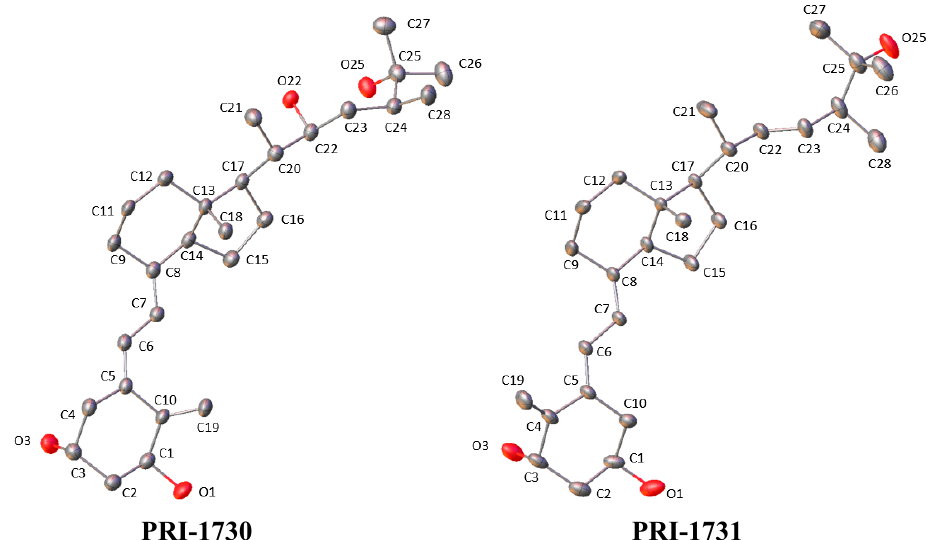
Figure 7. Displacement ellipsoids (50% probability level) of the molecular structure obtained with the TAAM refinements of PRI-1730 and PRI-1731. H-atoms were omitted for clarity.